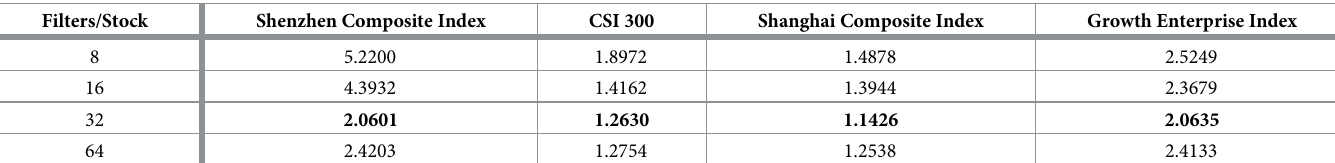
Table 4. MAPE values of index stocks in convolution kernels with different numbers (%). Filters/Stock